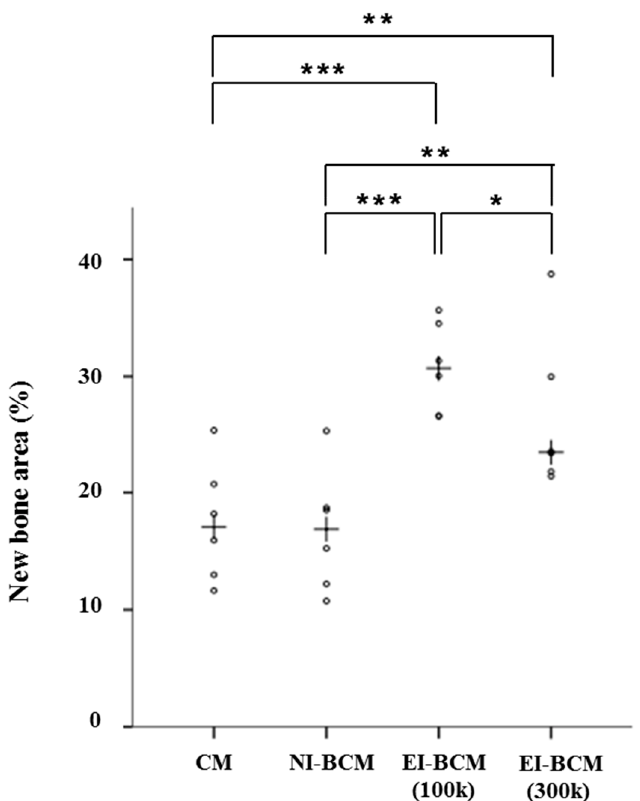
Figure 13. Scatter plots and median (crosses) new bone area percentages (%) at 8 weeks after surgery (* p < 0.05, ** p < 0.01, *** p <